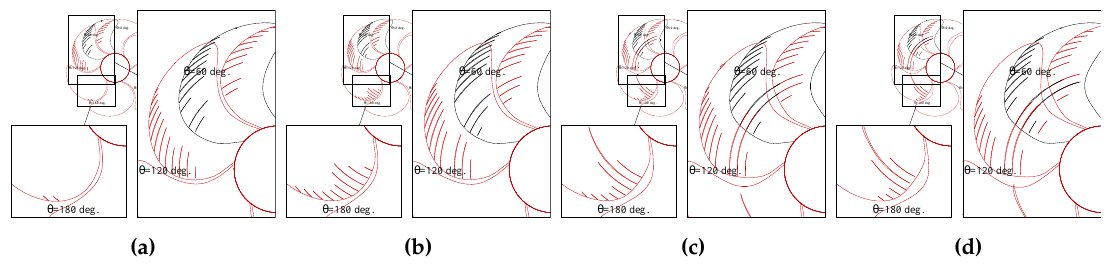
Figure 26. Cavitation performance of propeller case Opt-6. ( a ) Opt-6-11-104; ( b ) Opt-6-11-334; ( c ) Opt-6-11-339; ( d )